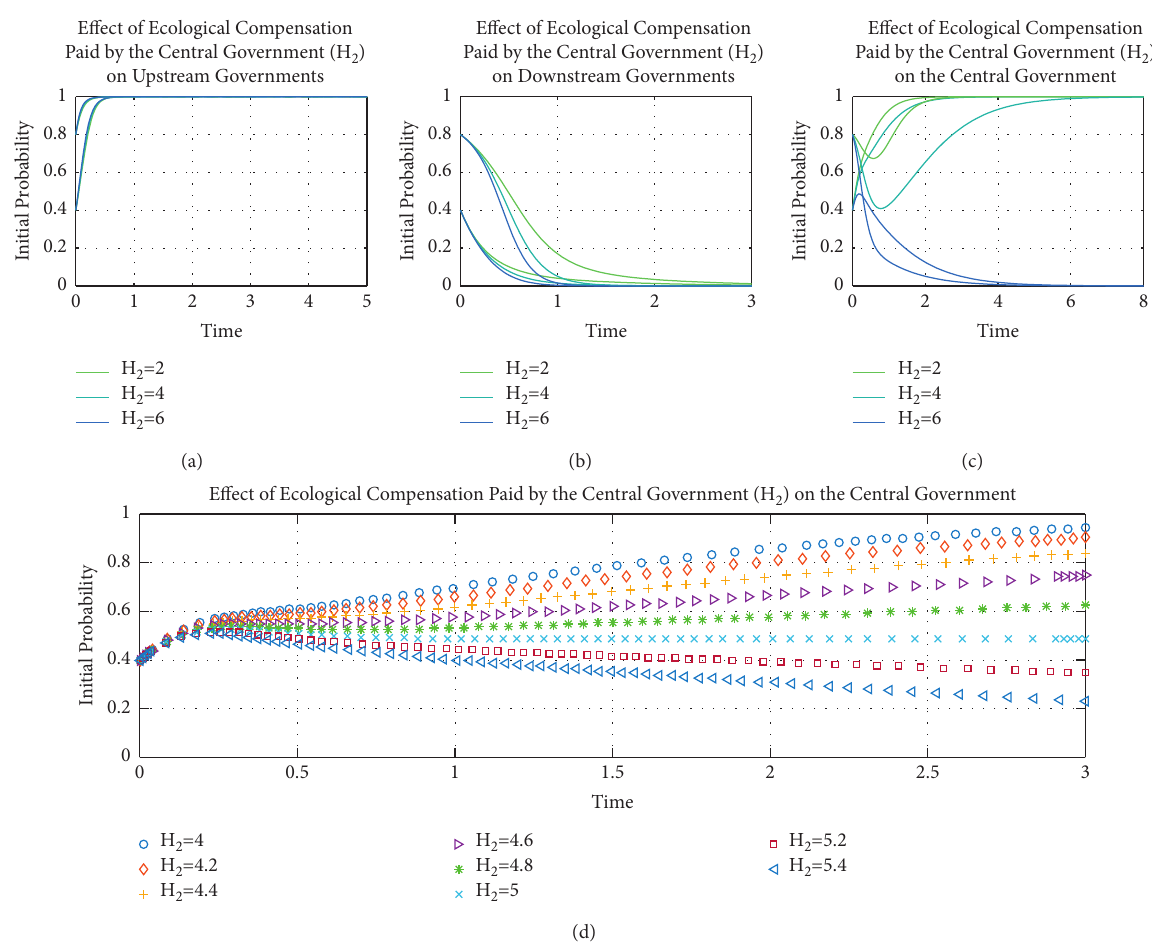
Figure 7: The effect of the ecological compensation paid by the central government ( H compensation paid by the central government ( H ) on upstream governments. (b) Effect of the ecological compensation paid by the central 2 ) on downstream governments. (c) Effect of the ecological compensation paid by the central government ( H government ( H 2 central government. (d) Effect of the ecological compensation paid by the central government ( H